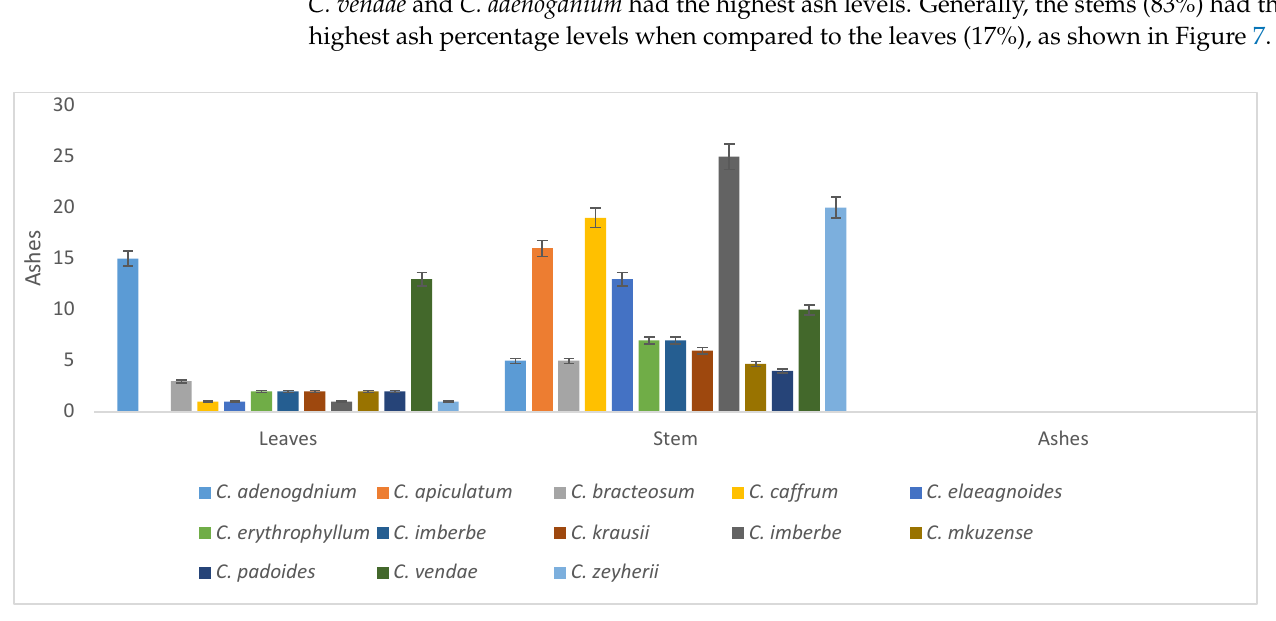
Figure 7 . Ash percentage of the leaves and stems of the Combretum species. Figure 7. Ash percentage of the leaves and stems of the Combretum species.